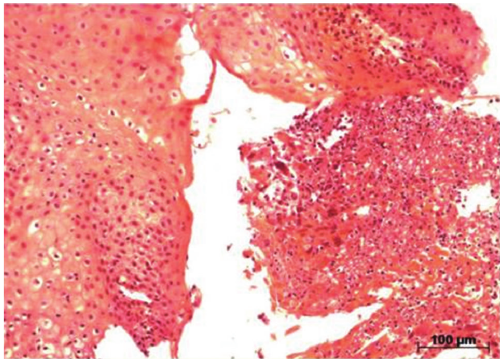
Figure 2: Anatomic pathological examination of the esophagus showing ulceration with presence of multinucleated cells with overlappingnucleiandground-glassaspect,consistentwithherpetic infection (hematoxylin-eosin).